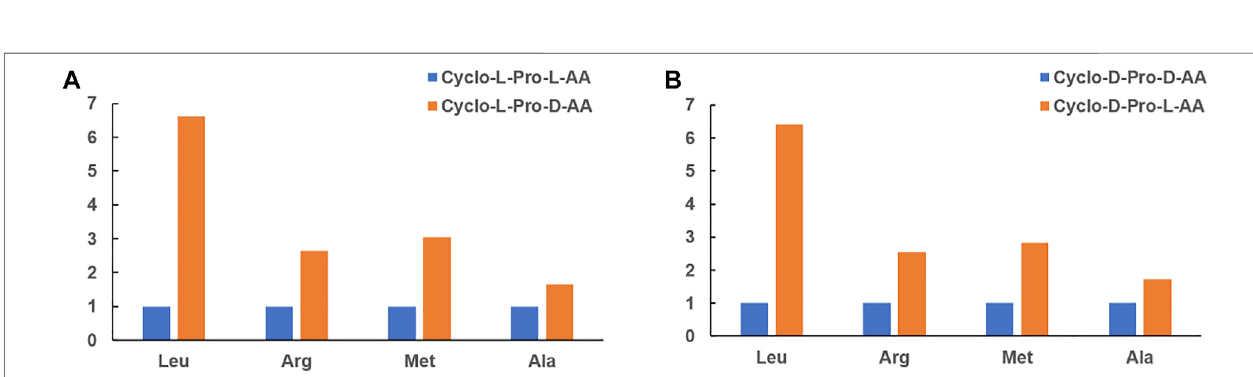
FIGURE 4 | The relative intensity of UV- absorption of the cyclo-Pro-AAs at 210 nm in these reactions. (A) Bar graph representation of the reaction L-Pro with four L-/D-AAs, respectively. (B) Bar graph representation of the reaction D-Pro with four L-/D-AAs, respectively.